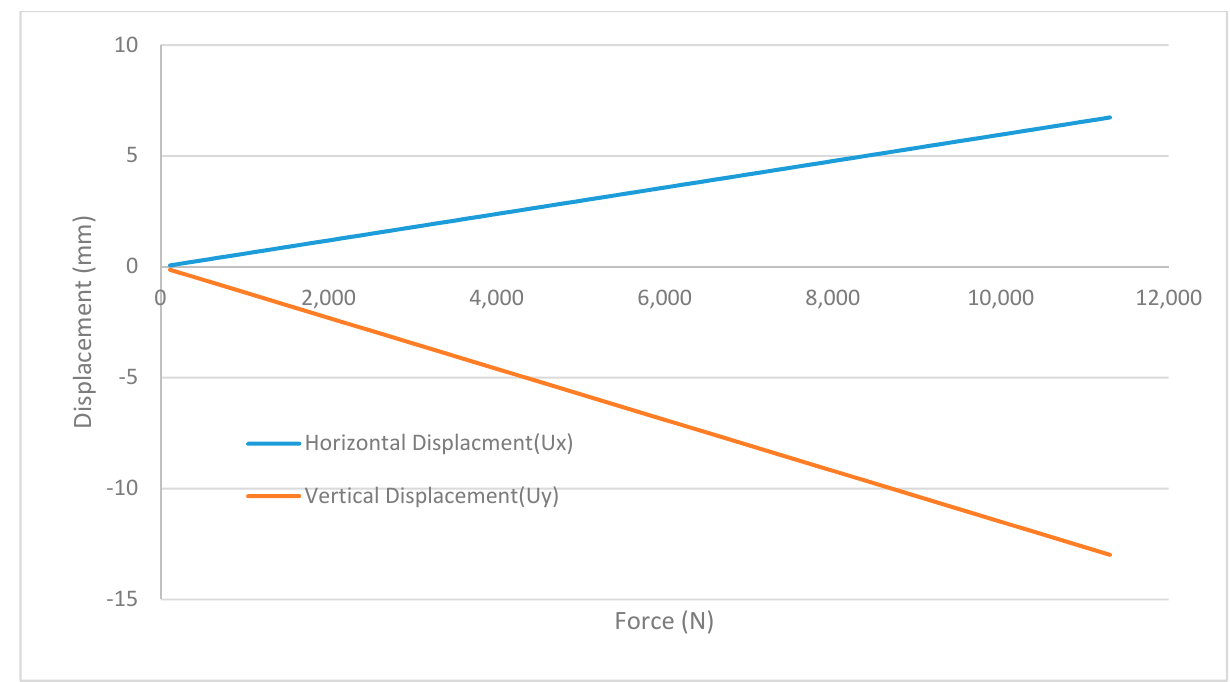
Figure 19. Horizontal and vertical displacements at node 20, element 1126 with coordinate details: ( x = 0, y = 0.25, z = − 4) and 10% FA.